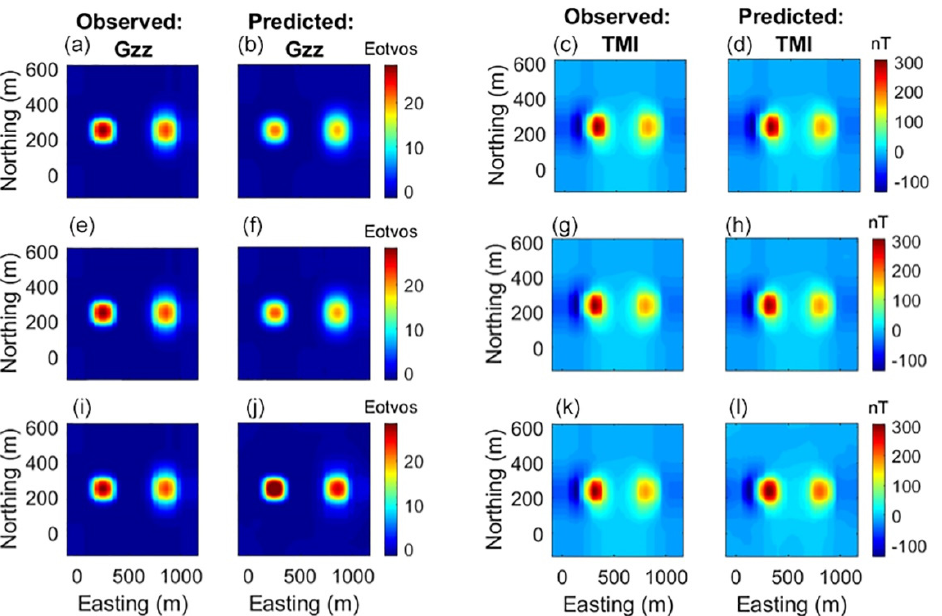
Figure 3. Model study. Panels ( a , b ) show observed and predicted Gzz gravity gradient data inverted standalone, respectively. Panels ( c , d ) show observed and predicted total magnetic intensity (TMI) data inverted standalone, respectively. Panels ( e , f ) show observed and predicted Gzz gravity gradient data inverted with Gramian constraints, respectively. Panels ( g , h ) show observed and predicted TMI data inverted with Gramian constraints, respectively. Panels ( i , j ) show observed and predicted Gzz gravity gradient data inverted with joint focusing, respectively. Panels ( k , l ) show observed and predicted TMI data inverted with joint focusing, respectively.